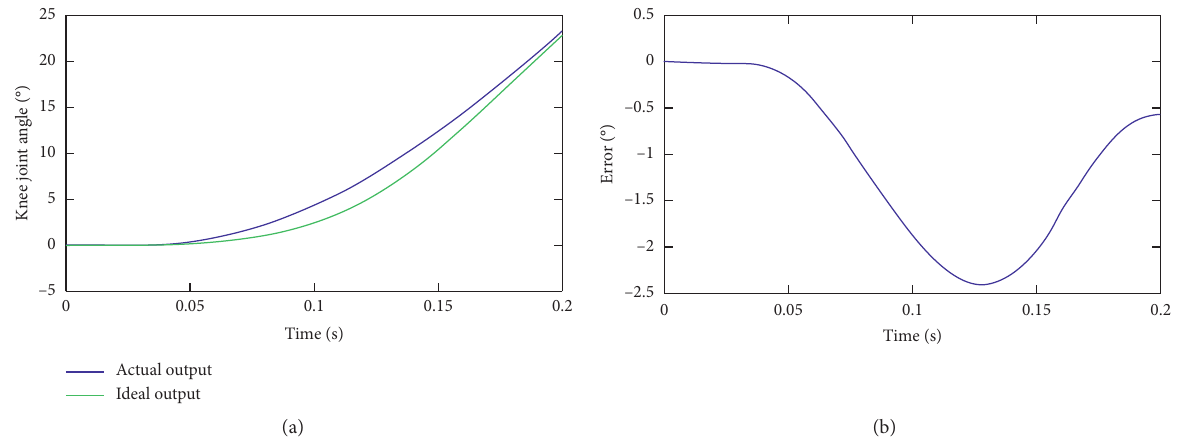
Figure 16: The tracking curve and the tracking error of knee